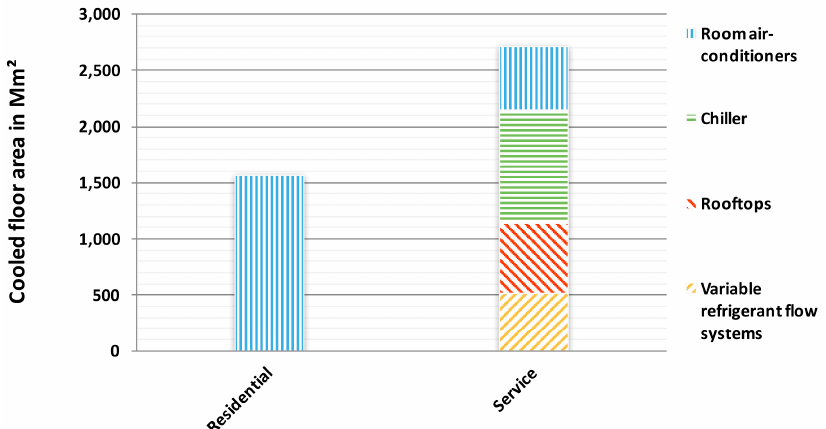
Figure 6. Distribution of cooled floor area per type, residential and service sectors, EU15 (see references in the Appendix A, Table A1).